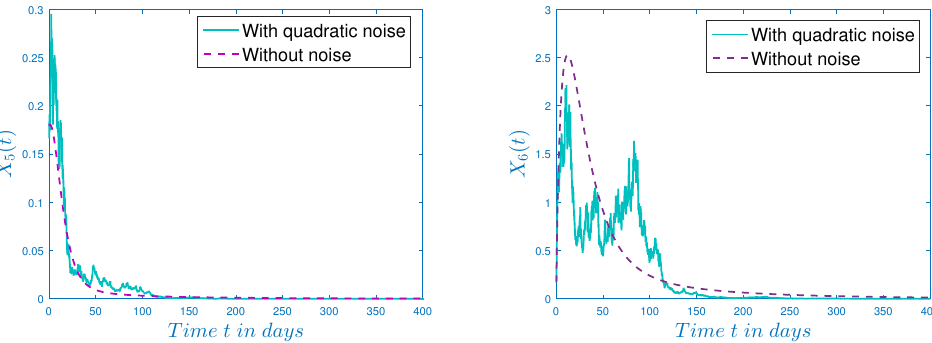
Figure 1. Numerical plot of the stochastic paths X k , k = 1,2,3,4,5,6 and their associated deterministic trajectories. The estimated deterministic values are selected from Table 2 and the stochastic amplitudes are chosen as follows: Ξ 1 (cid:96) = 0.07, Ξ 2 (cid:96) = 0.17, Ξ 3 (cid:96) = 0.1835, Ξ 4 (cid:96) = 0.764, Ξ 5 (cid:96) = 0.148, Ξ 6 (cid:96) = 0.141, Ξ = 0.012, Ξ = 0.027, Ξ = 0.0135, Ξ = 0.024, Ξ = 0.028, Ξ = 0.011. 2 q 3 q 5 q 6 q 1 q 4 q